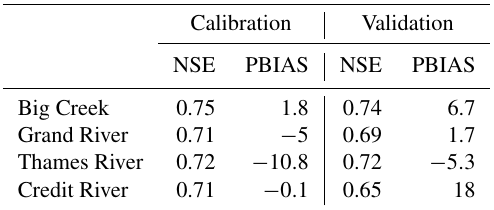
Table 3. Efficiency of the PRMS model for best-fit